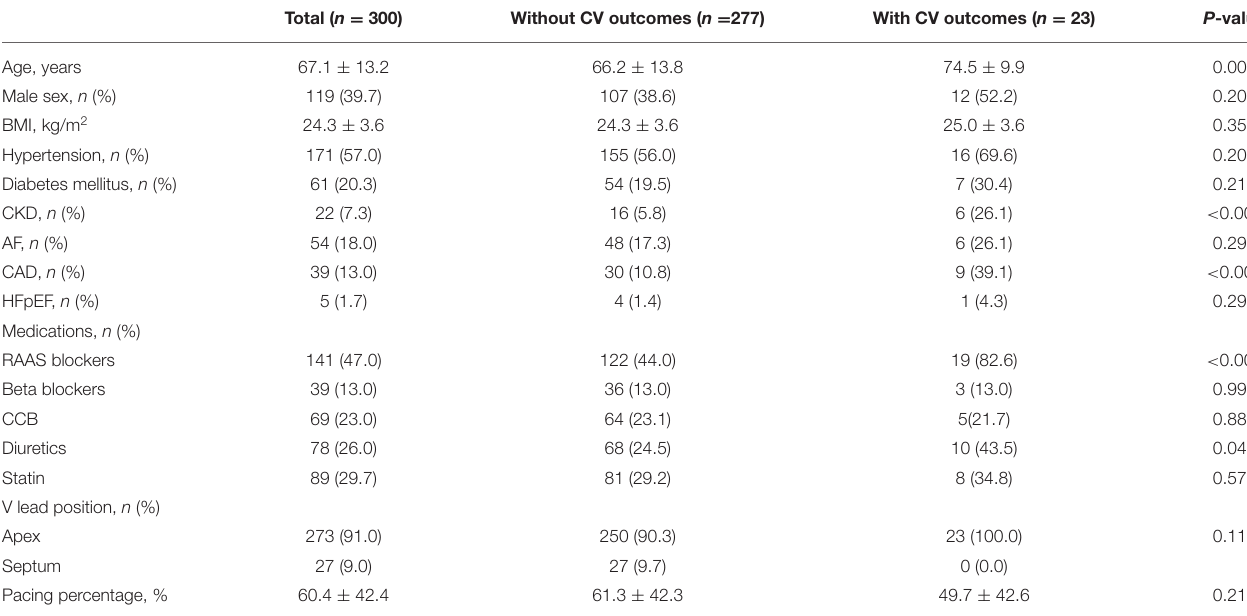
TABLE 1 | Baseline